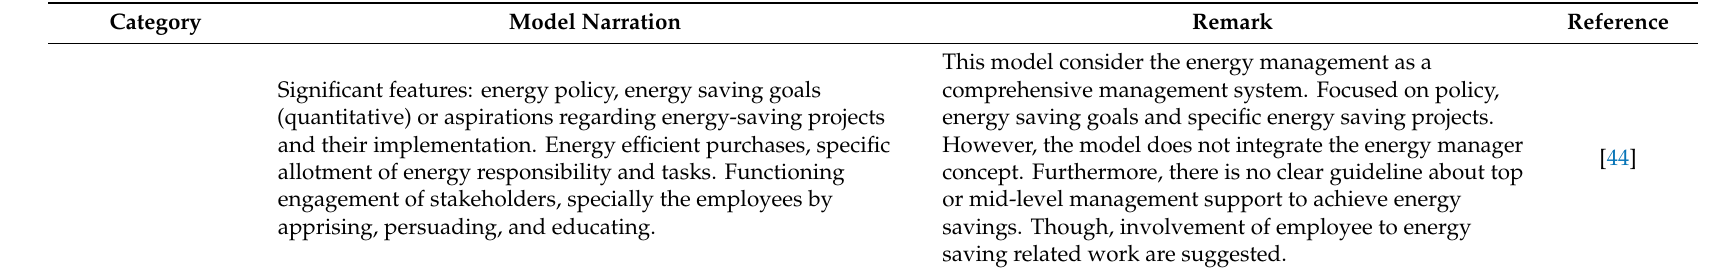
Table 5. Synopsis of the existing energy management assessment models. The table is an aggrandized approach of Trianni et al.